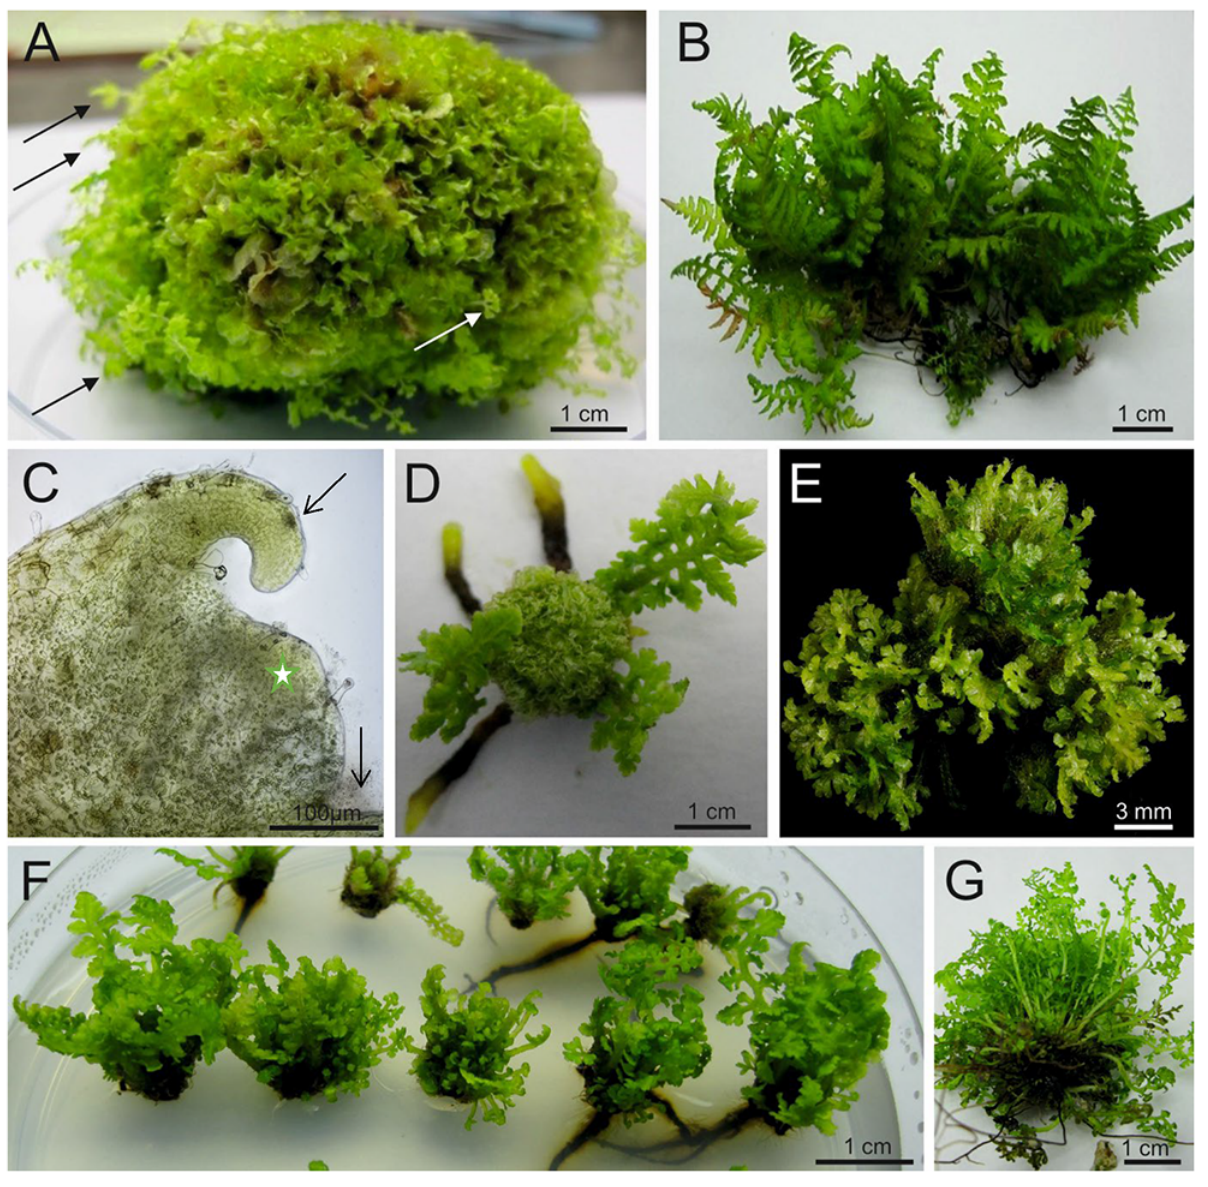
Figure 2 Various stages of the Cyathea smithii culture in the presence of 1/2 Murashige and Skoog (MS) medium supplemented with 2.0% sucrose. ( A ) Young sporophyte formation (arrows) using a clump of gametophytes during the 6 months of gametophyte initial culture on 1/2 MS medium supplemented with 2.0% sucrose. ( B ) Numerous sporophytes obtained from single gametophyte clump, which were the source of apical domes. ( C ) Living specimen of shoot apical dome (star) with leaf primordia (arrows) (Vanox AHBT3; Olympus, Japan). ( D ) Response of the apical dome on 1/2 MS medium supplemented with 5 μM thidiazuron [TDZ; 1-phenyl-3-(1,2,3-thiadiazol-5-yl)-urea)] and 0.25 μM naphthalene acetic acid (NAA) aer 3 months. Note: Developed leaves which determine development were present when explants were isolated and three roots indicated the general organ development pattern. In the center, a huge number of sporophyte primordia is present. ( E ) Post-TDZ treatment culture of the apical dome maintained on hormone-free medium aer 3 months. ( F ) Response of apical dome on 0.01 μM TDZ and 0.25 μM NAA aer 3 months of culture. Note: Development of numerous leaf primordia, indicating numerous young sporophytes with or without roots. ( G ) Numerous regenerants derived from TDZ culture aer 6 months on hormone-free medium. At this stage, the evaluation of developmental data with recognition of particular plants (note their fiddleheads) was